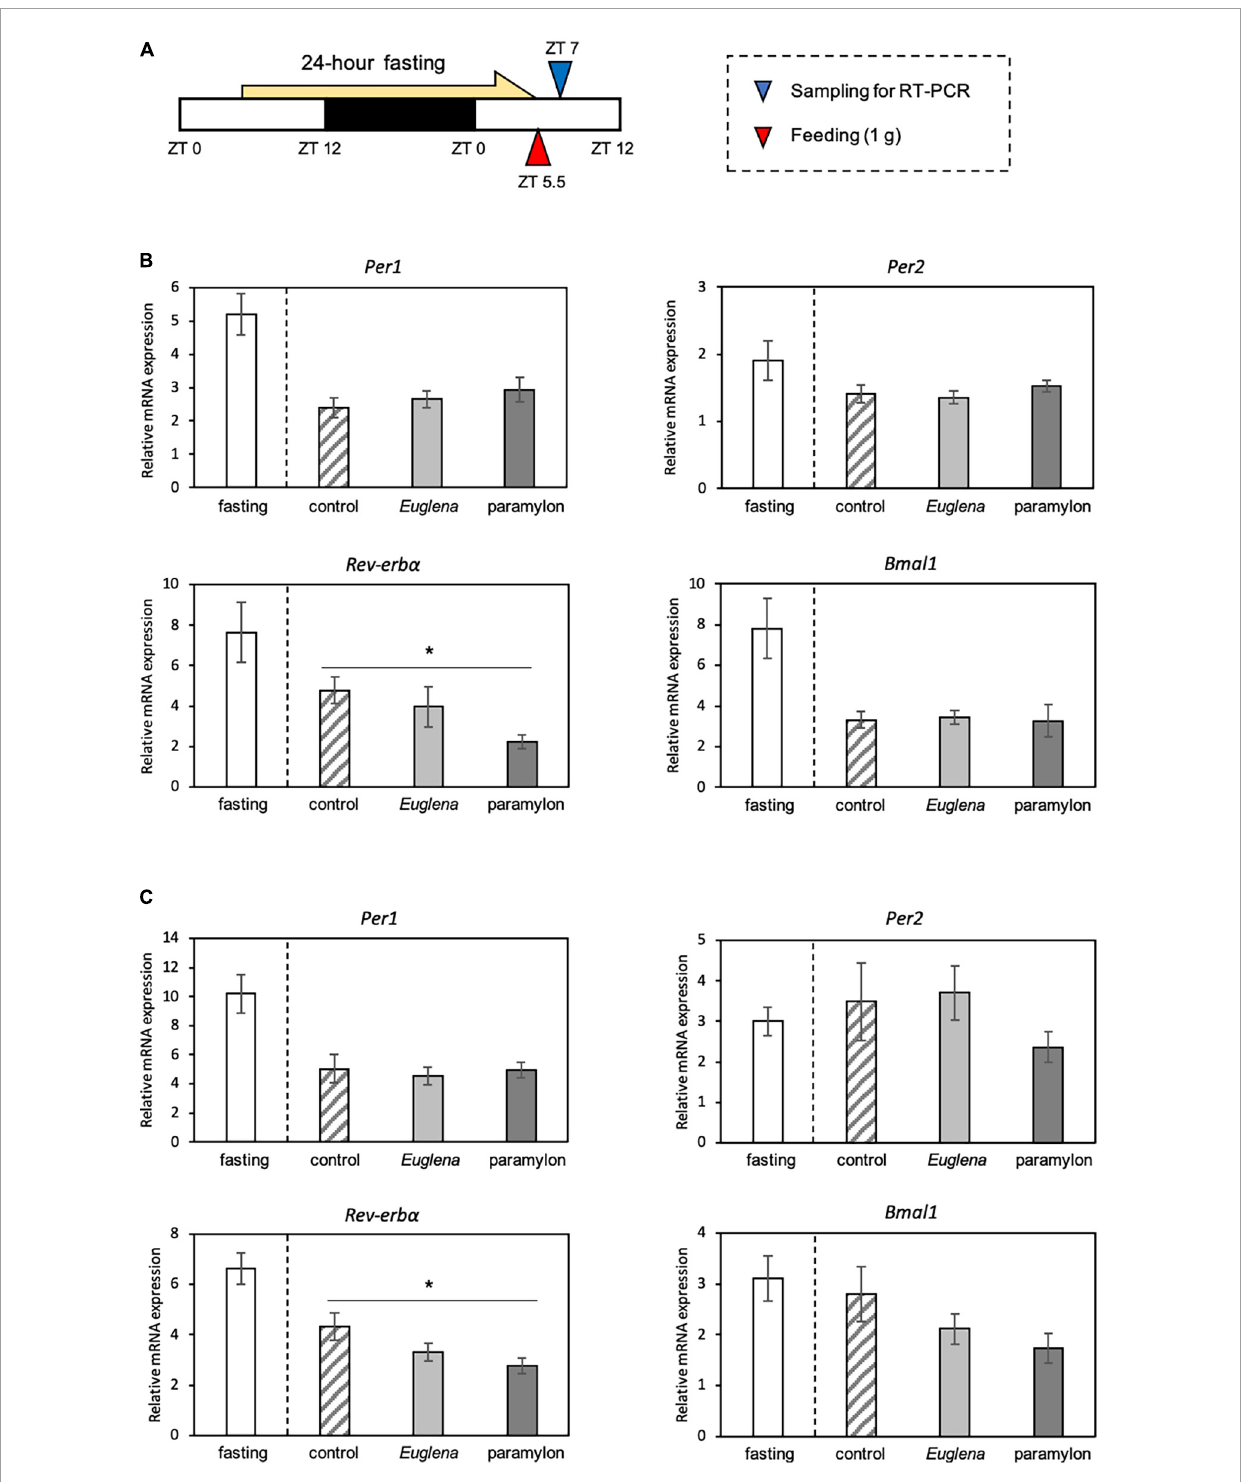
FIGURE2 The effects of Euglena and paramylon on the expression of genes related to the clock. (A) Experimental schedule. The blue arrowhead indicates the sampling time, and the red arrowhead indicates the feeding time. (B) Real-time RT-PCR analysis of Per1, Per2, Rev-erba, and Bmal1 mRNA expression in the liver of mice. (C) Real-time RT-PCR analysis of Per1, Per2, Rev-erba, and Bmal1 mRNA expression in the jejunum of mice. Values are expressed as mean ± SEM ( n = 8). * p < 0.05, vs. control group (one-way ANOVA with Tukey’s multiple comparisons test).